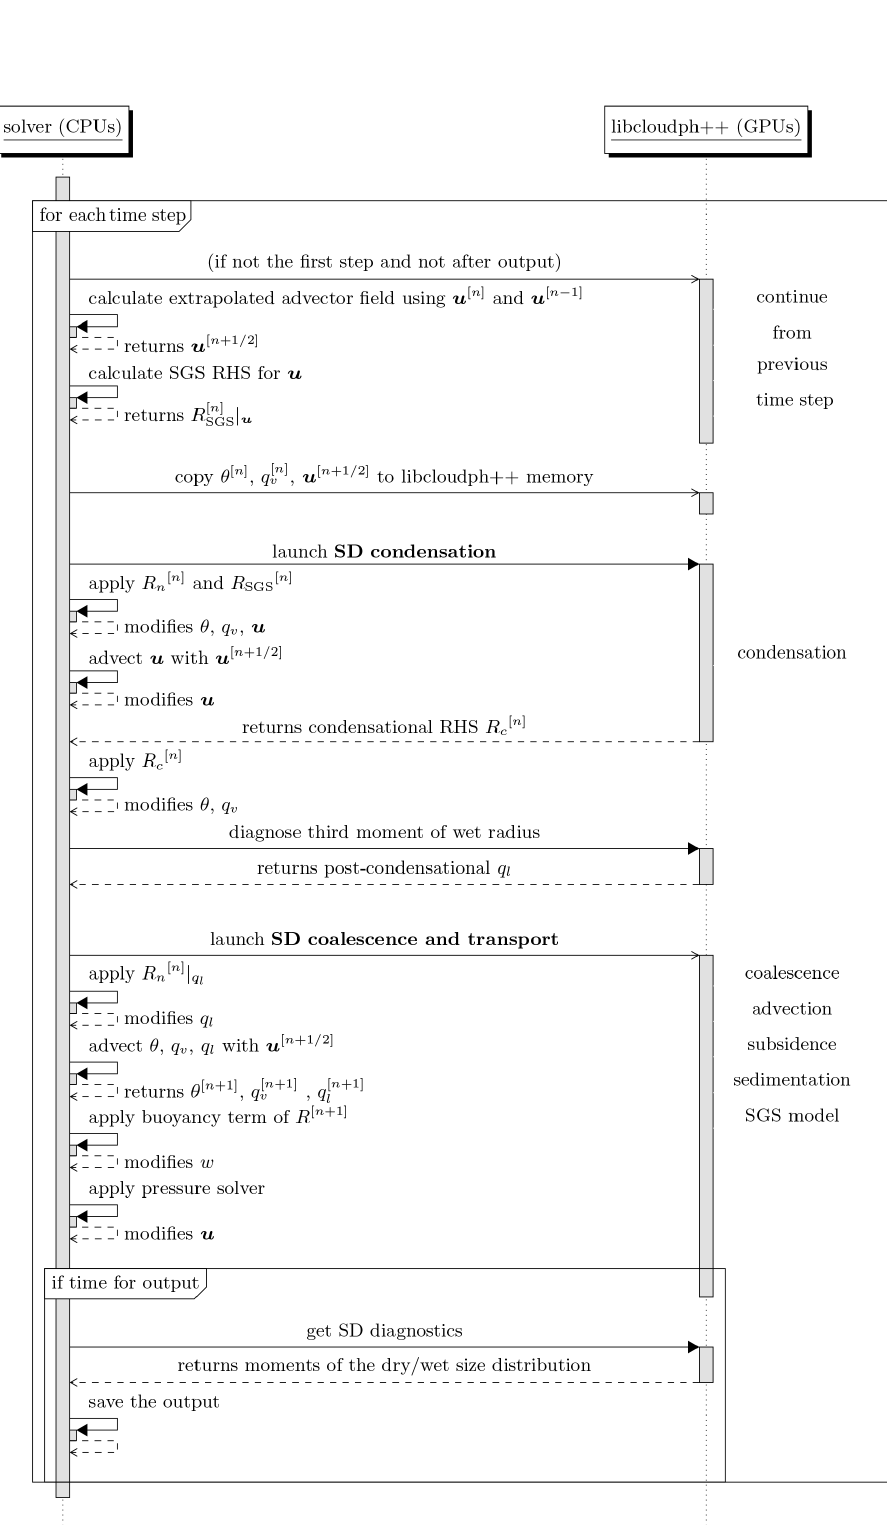
Figure 1. UML sequence diagram showing the order of operations in the UWLCM 2.0 model. Right-hand-side terms are divided into condensational, non-condensational and subgrid-scale parts; R = R c + R n + R SGS . Other notation follows Dziekan et al. (2019).